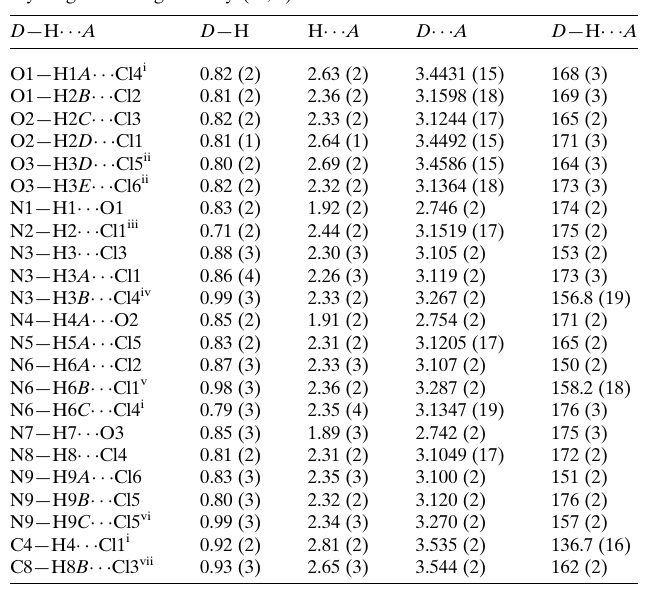
Table 1 Hydrogen-bond geometry (A˚ , (cid:5) ).